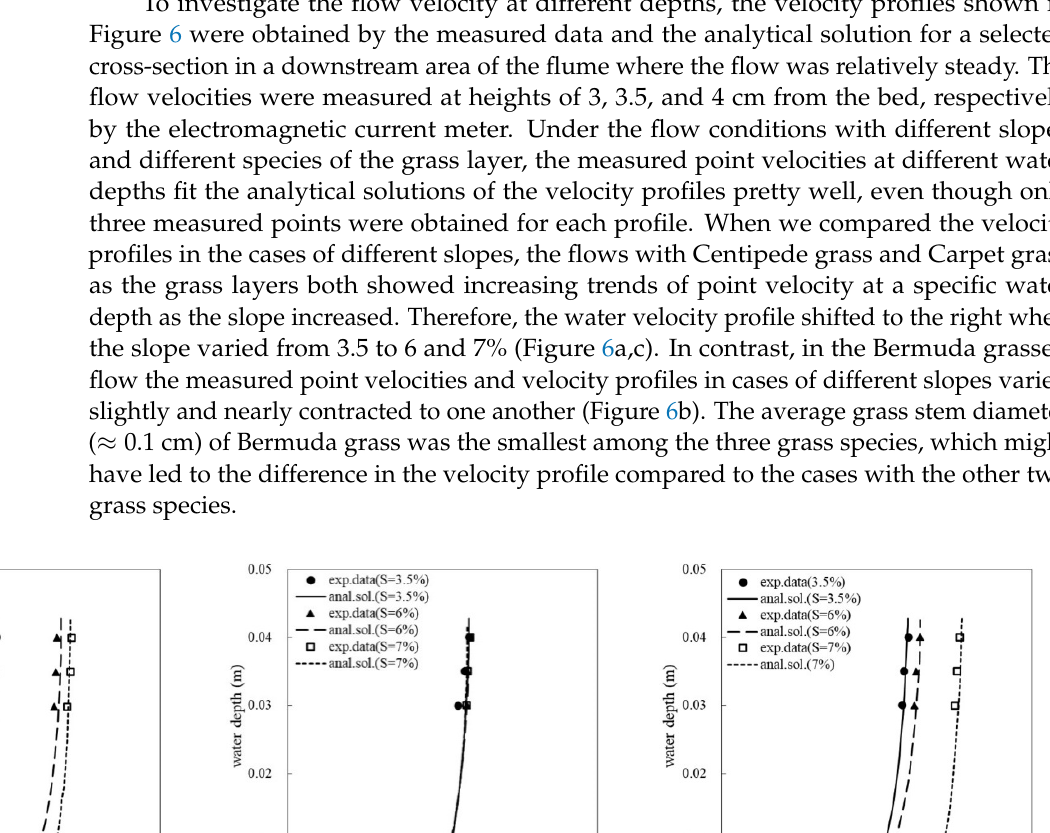
Figure 5. Average flow velocities at different relative heights for Carpet grass with bed slopes of ( a ) 3.5%, ( b ) 6%, and ( c ) 7%.